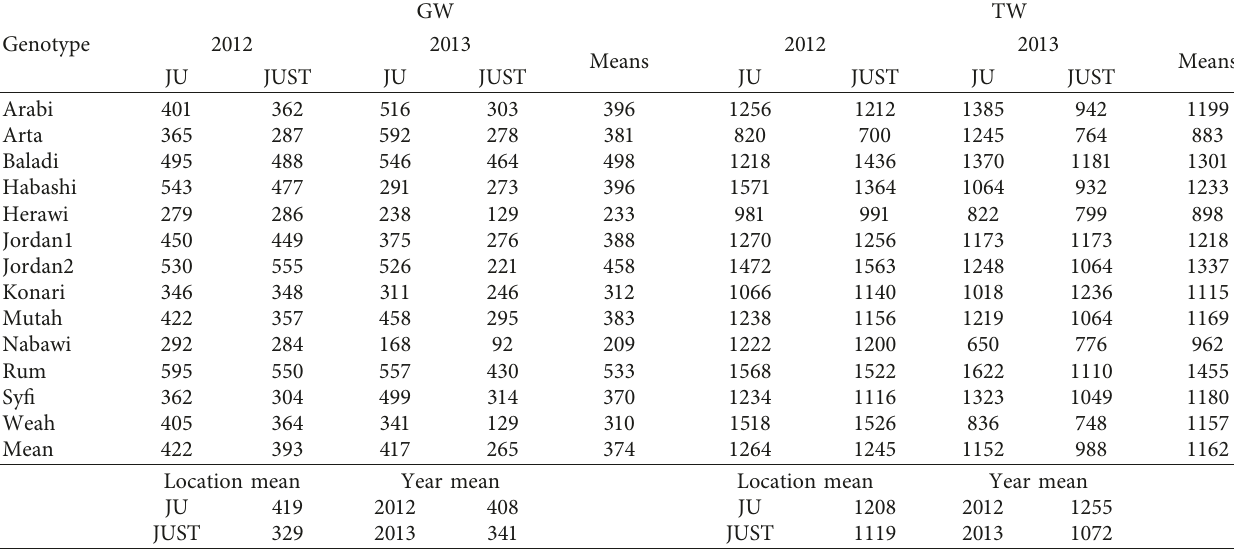
Table 4: Grain weight (GW) and total weight (TW) mean values of 13 barley genotypes across four tested environments.